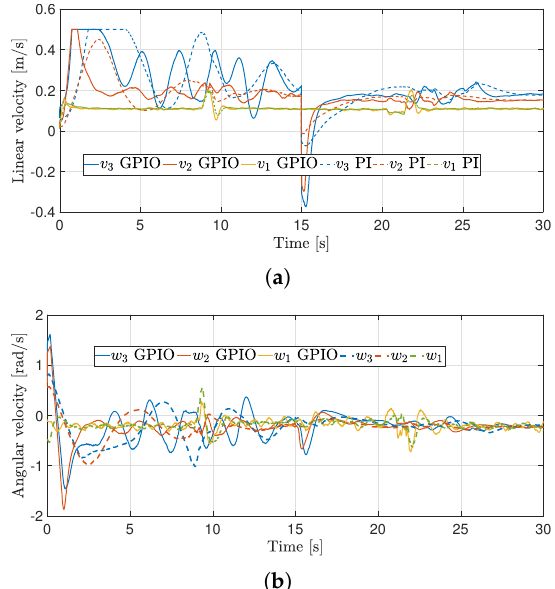
Figure 15. Control inputs for the robots for the second experiment. ( a ) Longitudinal velocities. ( b ) Angular